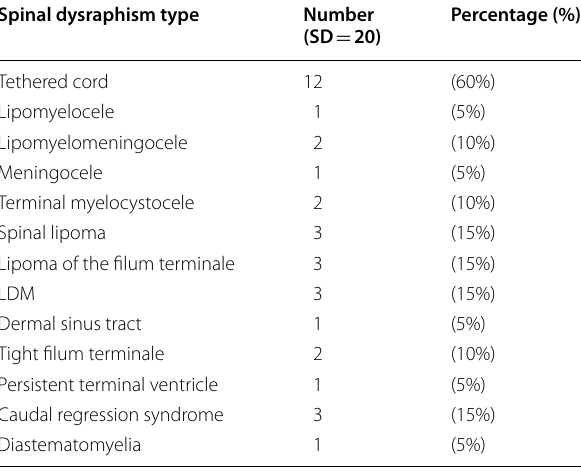
Table 2 Distribution of study population regarding subtypes of closed spinal dysraphism